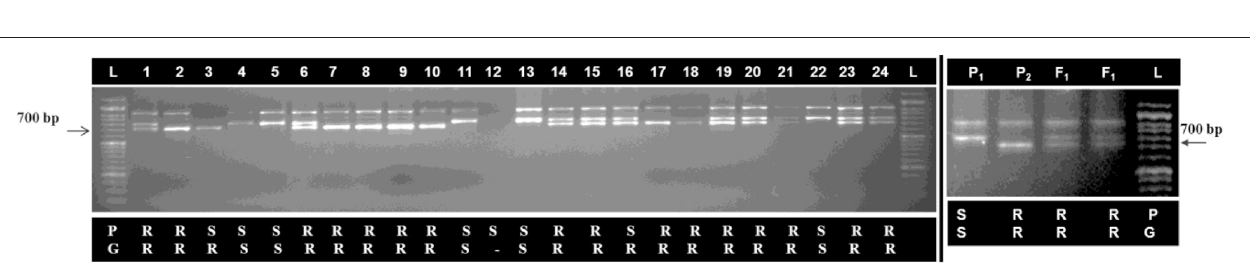
FIGURE 6 | Phenotyping of introgressed BC 1 for black rot disease. Disease reaction with ( Xcc race 1) in parental genotypes. (A) Susceptible “Pusa Sharad.” (B) Resistant “NPC-9.” (C) All interspecific hybrid (resistant). (D) Variations for disease in BC 1 plants.